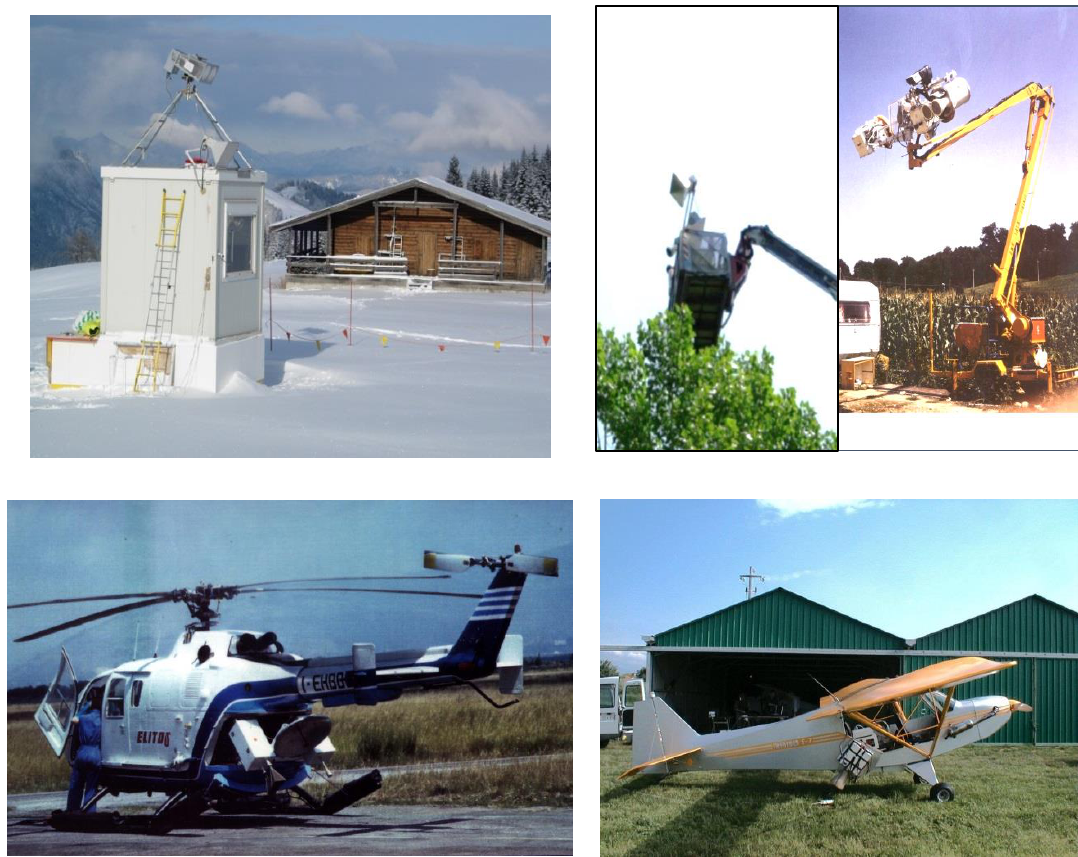
Figure 1. Installations of IROE microwave radiometers on several platforms: in a shelter on snow, on hydraulic booms on forest and agricultural fields, and on helicopter and ultra-light aircraft. The IFAC microwave instruments were total-power, self-calibrating, dual-polarized radiometers with an internal calibrator based on two loads at different temperatures (cold, 250 K ± 0.2 K, and hot, 370 K ± 0.2 K). The beamwidth of the corrugated conical horns was 20° at − 3 dB and 56° at − 20 dB for all frequencies and polarizations. Calibration checks were performed during the field experiments by means of absorbing panels of known emissivity and temperature and an internal noise source. Moreover, frequent observations of clear sky were performed. The measurement accuracy (repeatability) was better than ±1 K, with an integration time of 1 s [21].